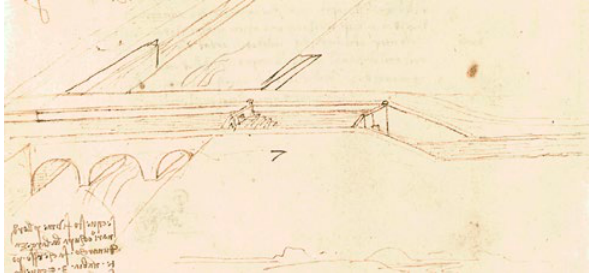
Figure 17. C.A., fol. 126v, detail: perspective view of the canal bridge.